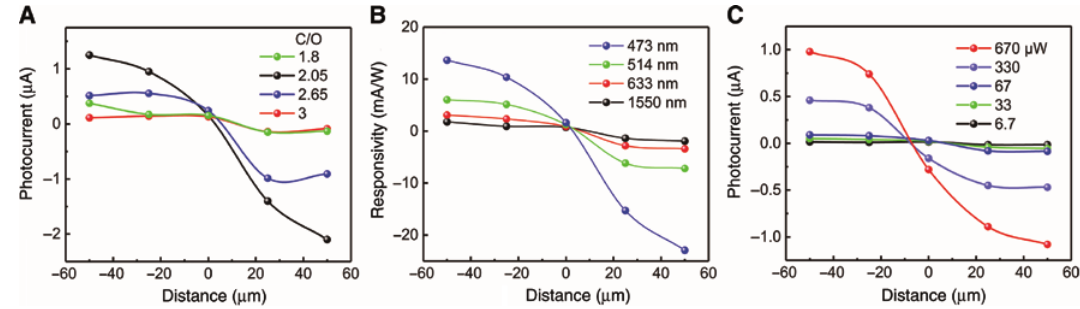
Figure 3: Photoresponse of rGO films at different positions of laser spots with (A) different C/O ratios (473 nm laser), (B) different laser wavelengths, and (C) different laser powers at 633